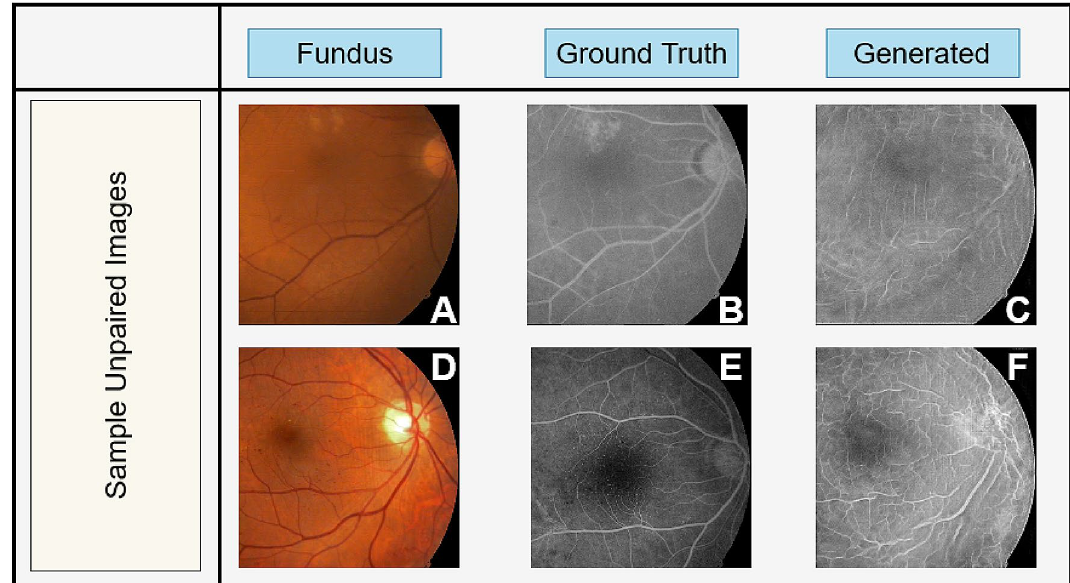
Figure 11. Results of the proposed GAN architecture on unpaired original Fundus images ( A,C ). Compared to the corresponding FA images as ground truth ( B,D ), the proposed architecture will produce un-natural images ( C,E ) on on-paired